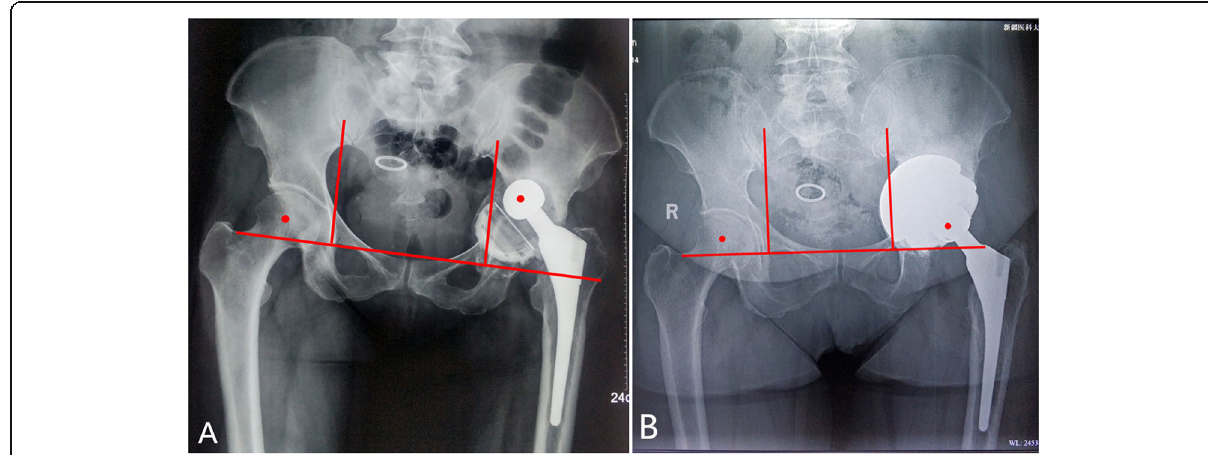
Fig. 1 A 60-year-old female patient sustained a loosening cup. A A Paprosky IIC defect. B The “ cup-in-cup ” reconstruction technique with 3 porous shells (out diameters of the shells from medial to lateral: 70 mm; 64 mm; and 58 mm). The center of rotation of the hip was restored